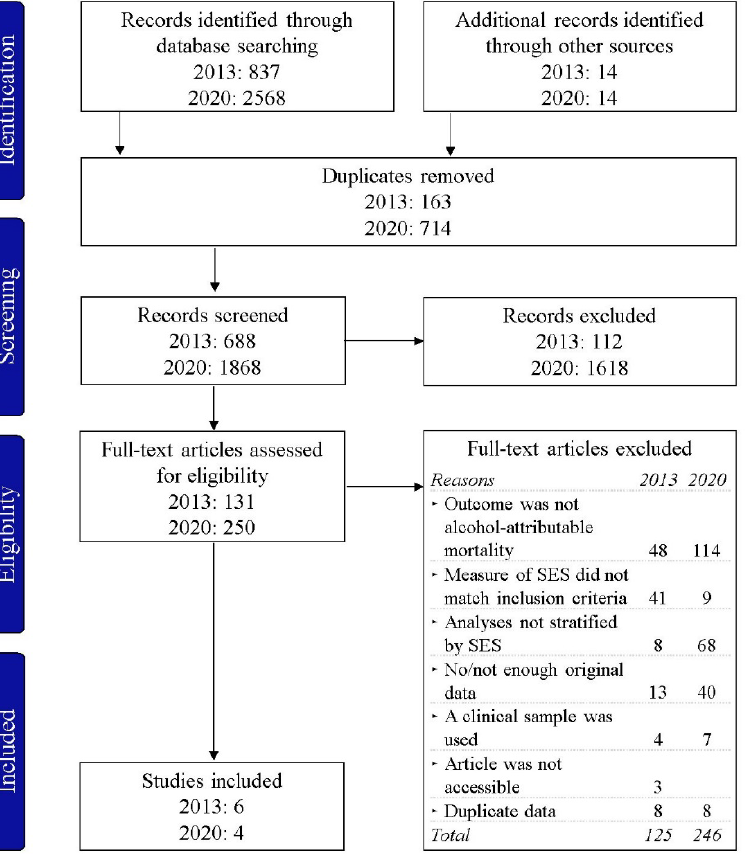
Figure 1. The PRISMA flow chart of the study selection for the search conducted in 2013 (including studies published up to February 2013) and 2020 (including studies published between January 2013 and August 2020). SES, socioeconomic status. Table 1. The characteristics of all studies included in the sex-stratified random-effect